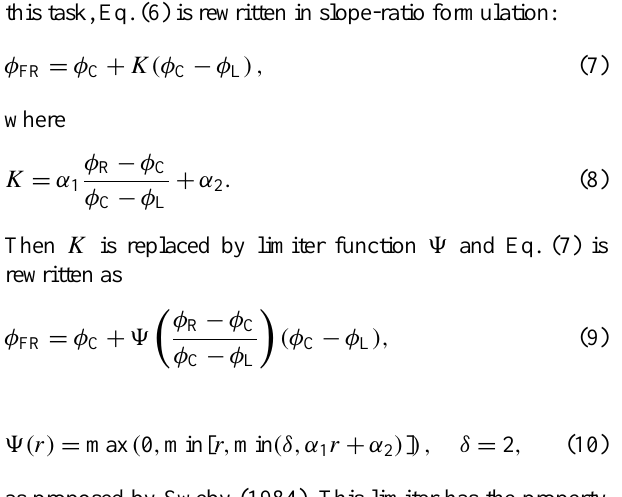
Figure 1. Possible configurations for cut cell intersection (cases 1–3) for different numbers of face intersection points (markers). The last two cases are excluded.